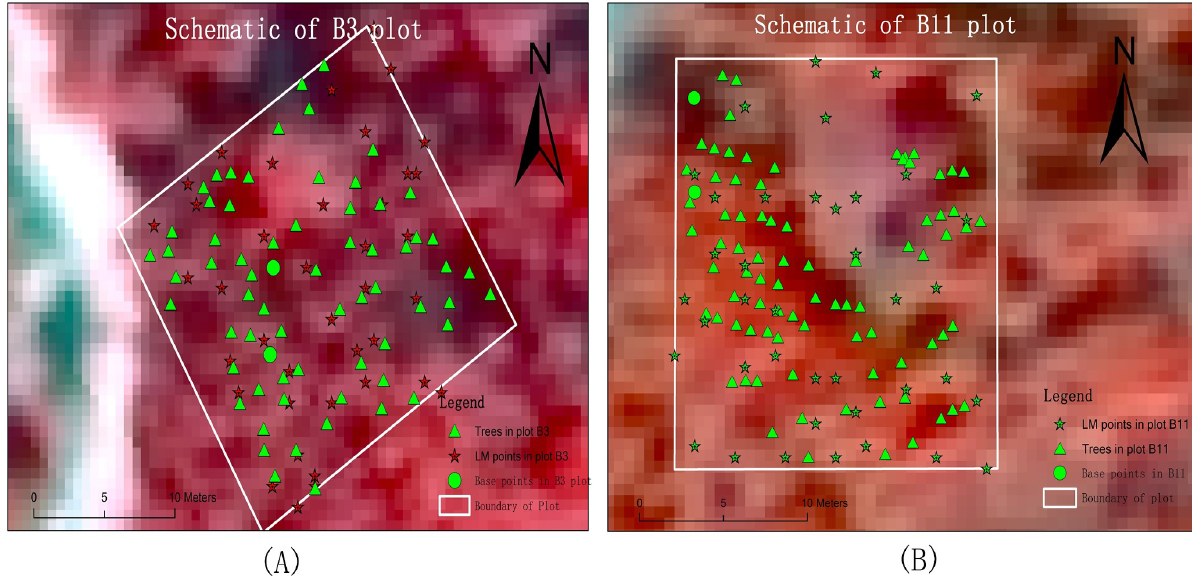
Fig 2. Sample plots geolocation in QuickBird fusion imagery with multispectral and panchromatic band and NDVI threshold is 0.2. (A) Sample plot B3. (B) Sample plot B11.